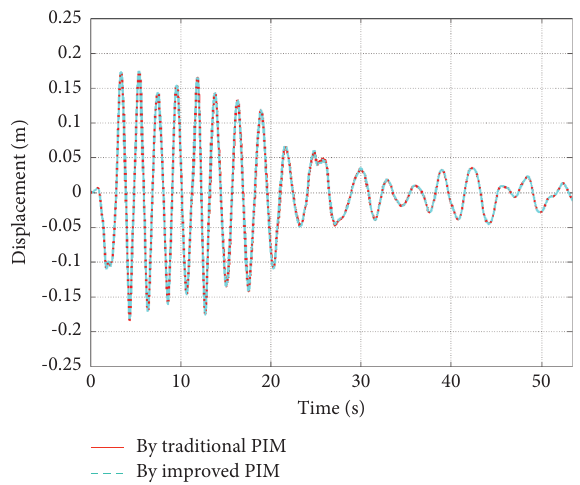
Figure 3: Time-history curve of pier top displacement under rare earthquake